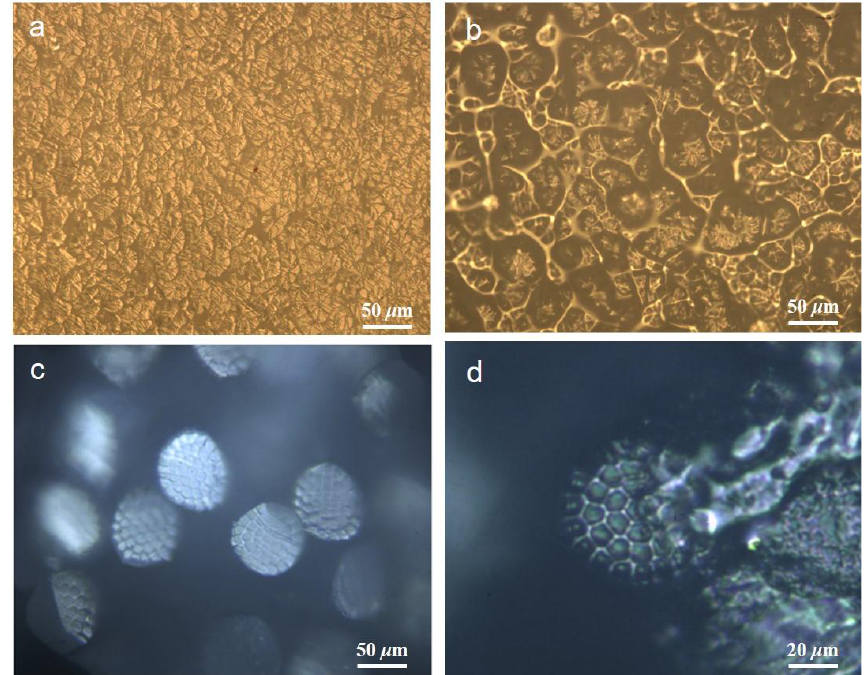
Figure 2. In situ dissolution diagram of lobe type and fibril matrix bicomponent fibers ( a ) before the dissolution of lobe type bicomponent fibers ( b ) after the dissolution of lobe type bicomponent fibers ( c ) before the dissolution of fibril matrix bicomponent fibers ( d ) after the dissolution of fibril matrix bicomponent fibers.